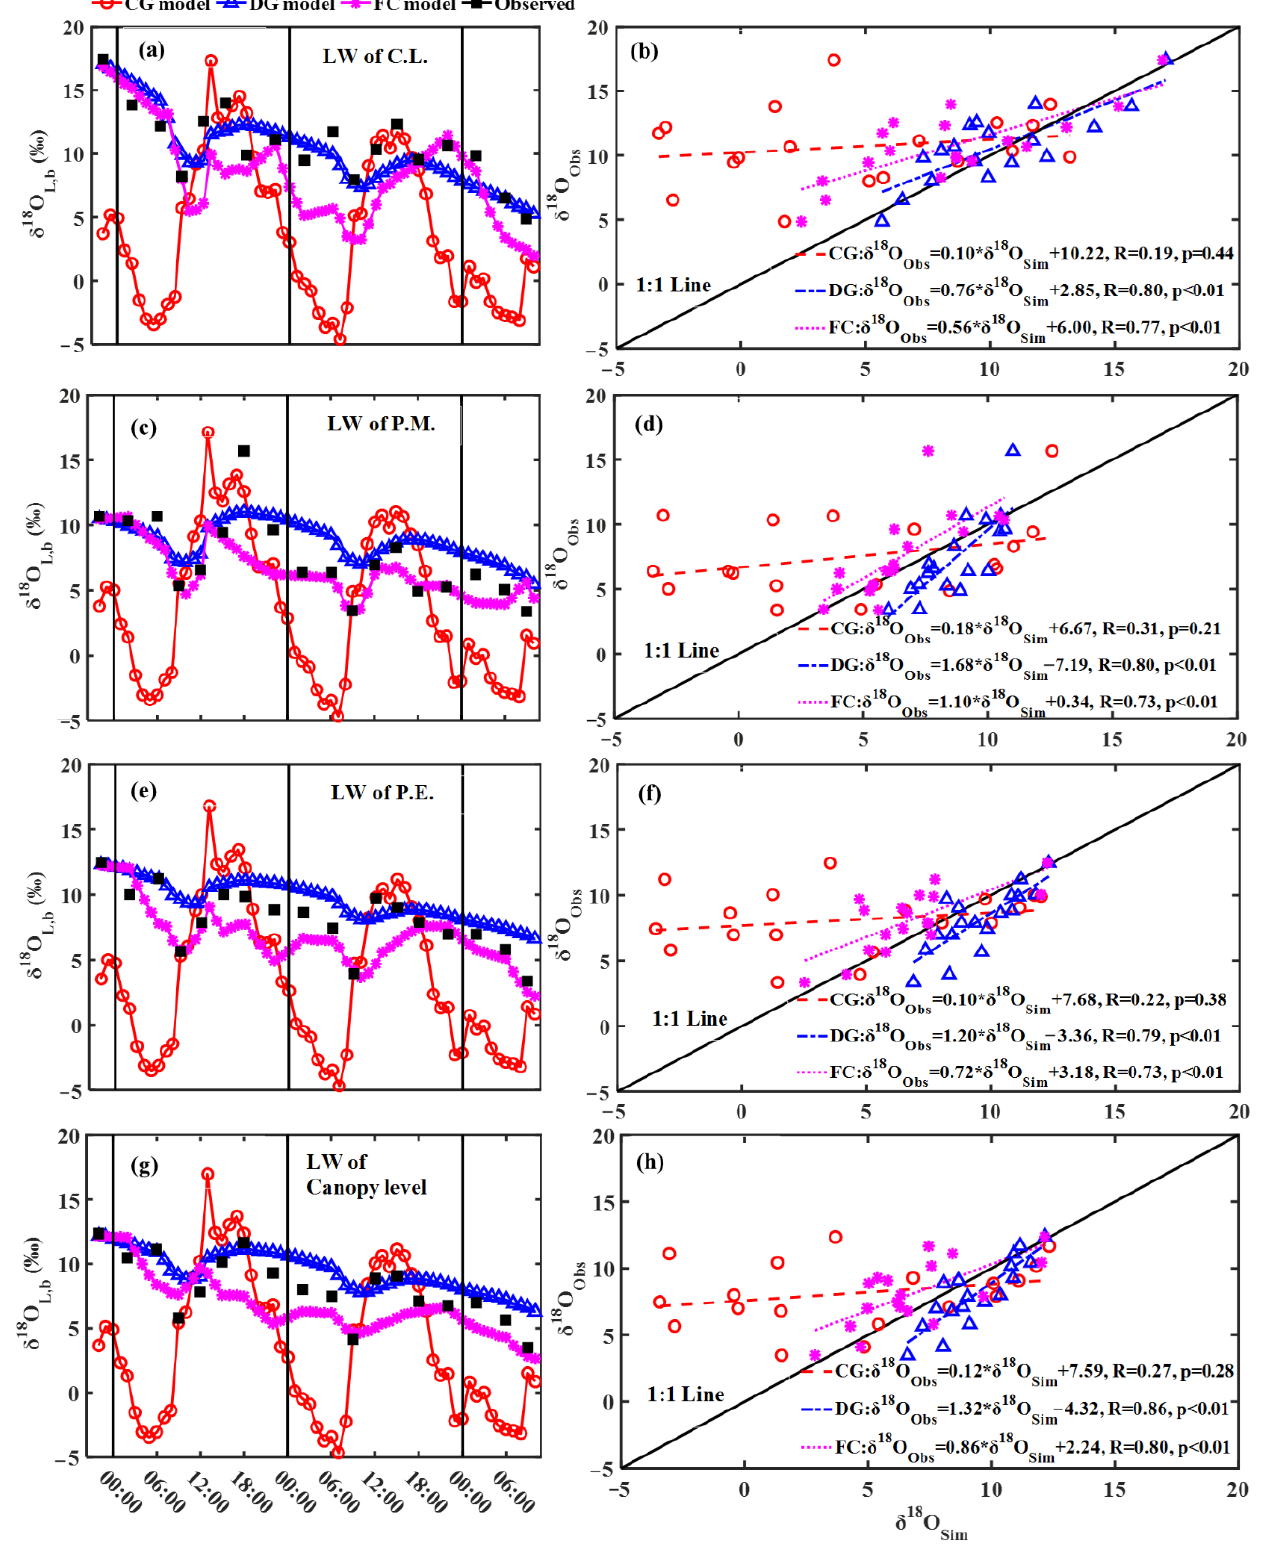
Figure 2. Diurnal variability in simulated with Craig–Gordon (CG), Dongmann (DG), and Farquhar–Cernusak (FC) models, and observed leaf water δ 18 O ( δ 18 O L,b ), and comparisons between simulated values ( δ 18 O Sim ) and observed values ( δ 18 O Obs ) for C. lanceolata (C.L., (a) and (b)), P. massoniana (P.M., (c) and (d)), P. elliottii (P.E., (e) and (f)), and canopy level ((g) and (h)). LW indicates leaf water.